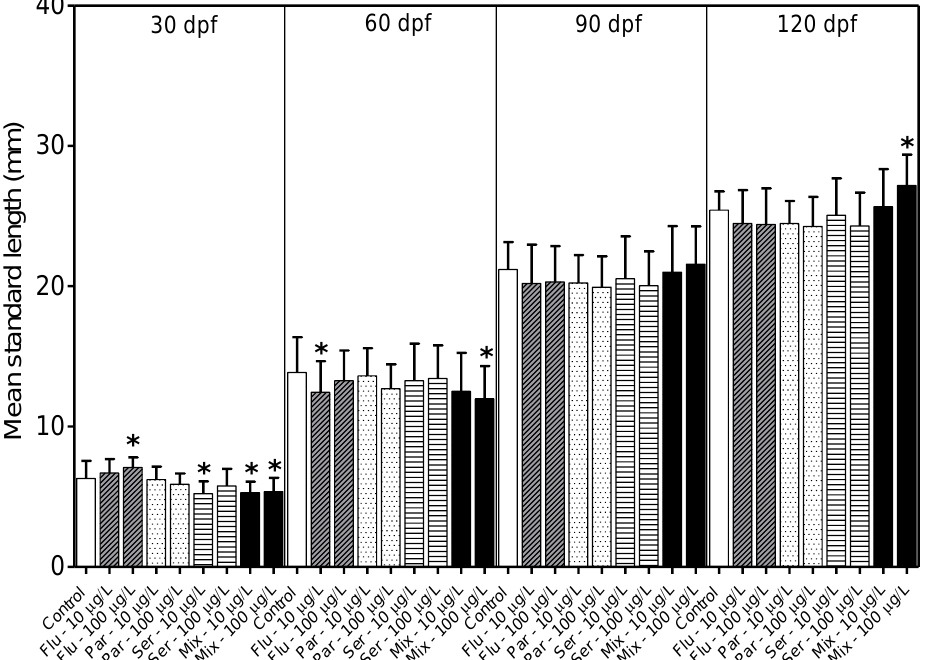
Figure 2. Mean standard length (mm) of fish measured at 30, 60, 90 and 120 days post fertilization (dpf). Flu—Fluoxetine; Par—Paroxetine; Ser—Sertraline; Mix—Mixture. Statistical significance with respect to the control fish group was determined using a one-way ANOVA followed by a Dunnett’s multiple comparisons test (* p < 0.05).